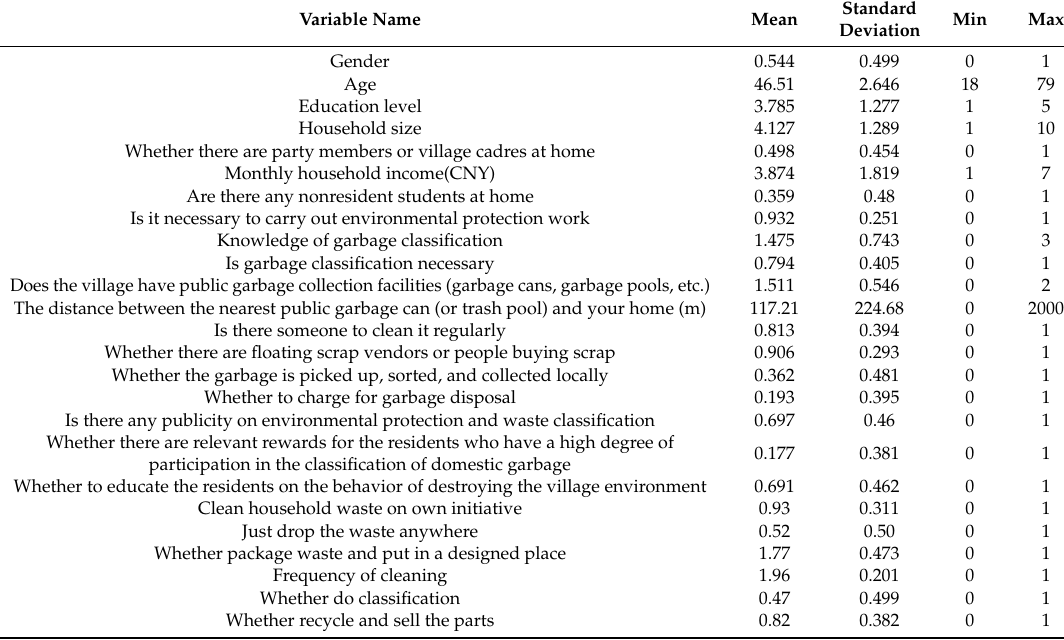
Table 3. Research descriptive